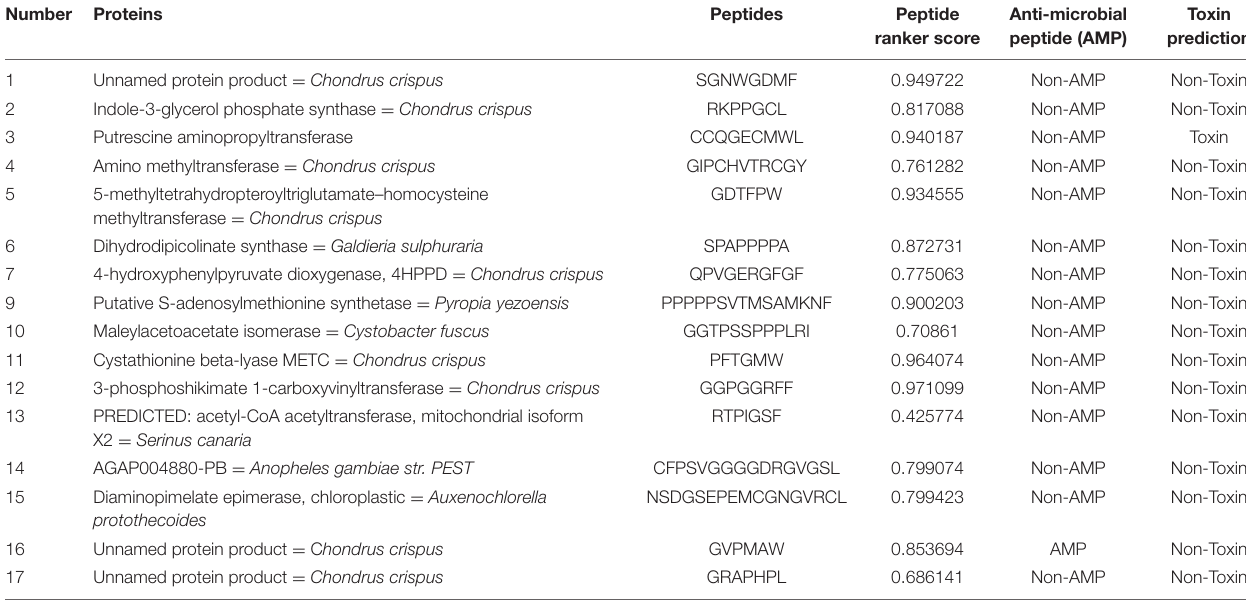
TABLE 3 | Selected potential bioactive peptides of the amino acid metabolism proteome predicted by in silico digestions with pepsin. Number Proteins Peptides Peptide